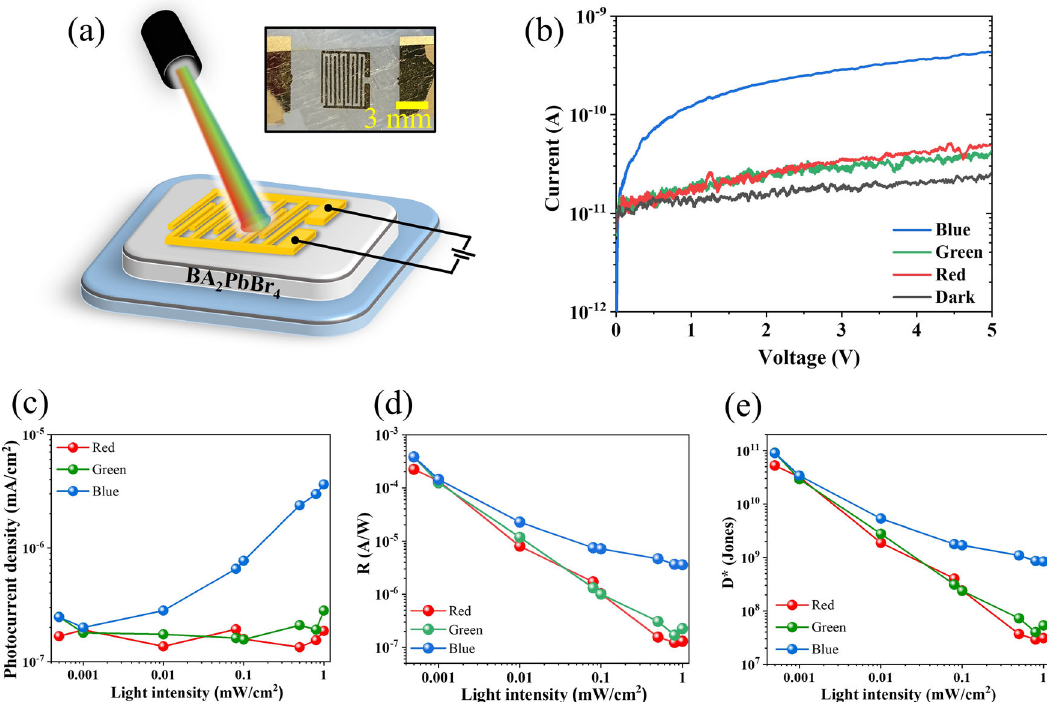
Fig. 4 BA 2 PbBr 4 photodetector characteristics under different incident light wavelengths. a Schematic illustration of BA 2 PbBr 4 photodetector. The insert photo is an optical image of the device. b The current – voltage curves of the photodetector measured in the dark and under various monochromatic lights; R, G, B represent the incident lights of red (634 nm), green (515 nm), and blue (447 nm). Light intensity-dependent performance of BA 2 PbBr 4 photodetector under red, green, and blue illumination at 5 V bias voltage: c photocurrent density, d responsivity (R), and e detectivity